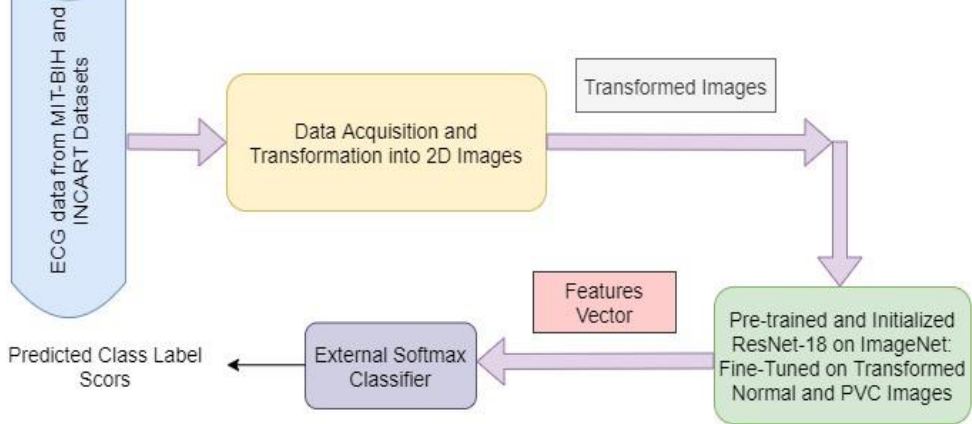
Figure 1. The proposed method overview using transfer learning on imbalanced datasets.